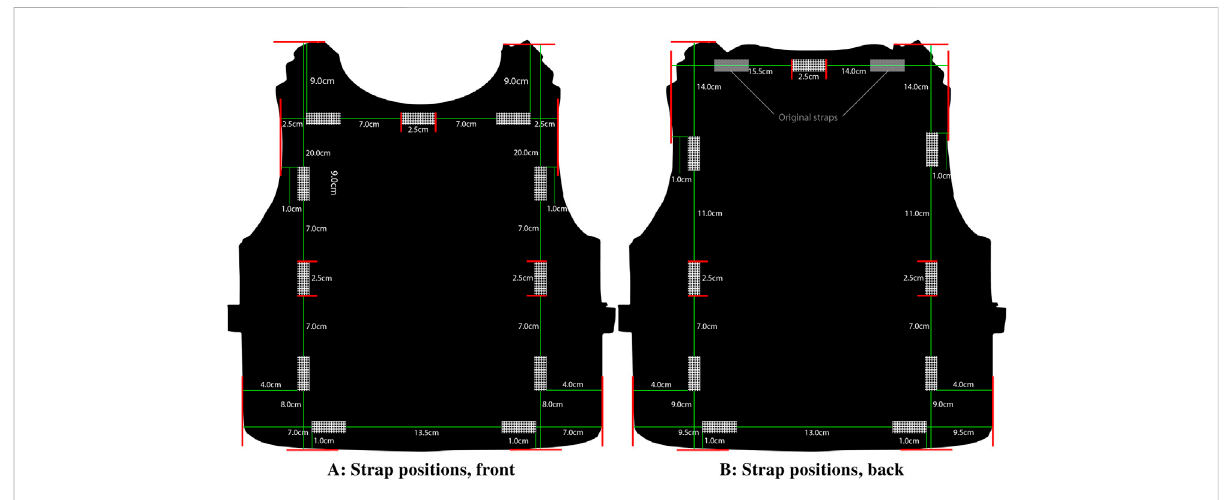
FIGURE 1 Tactical vest customized for supporting the force-feedback device platform: strap positions in front (A) and back (B)